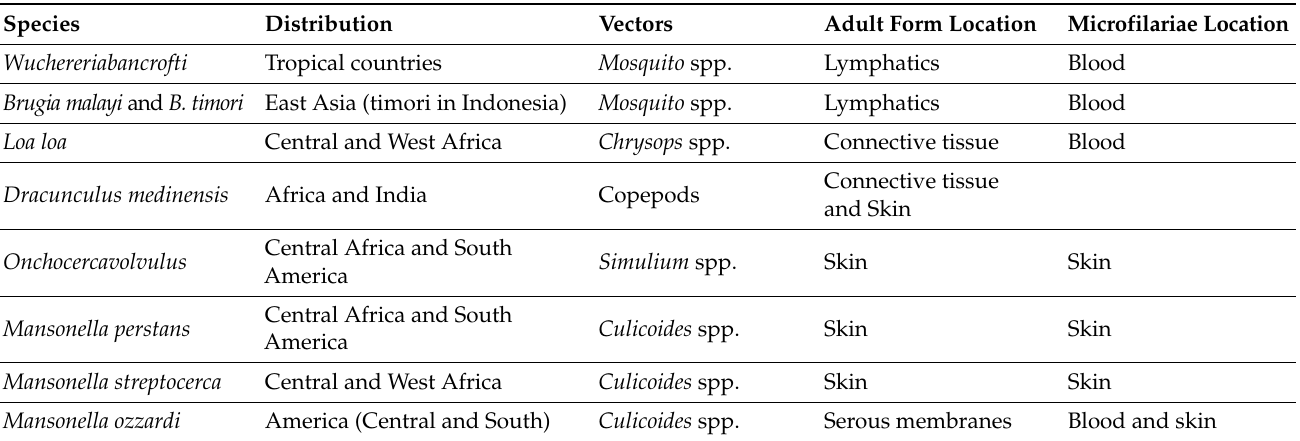
Table 1. Filarial parasites and Guinea